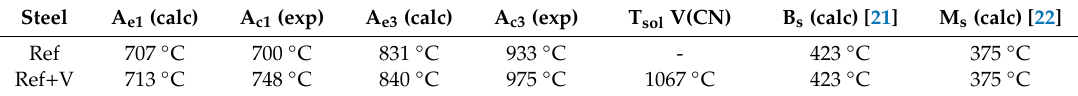
Table 2. Experimental and calculated transformation